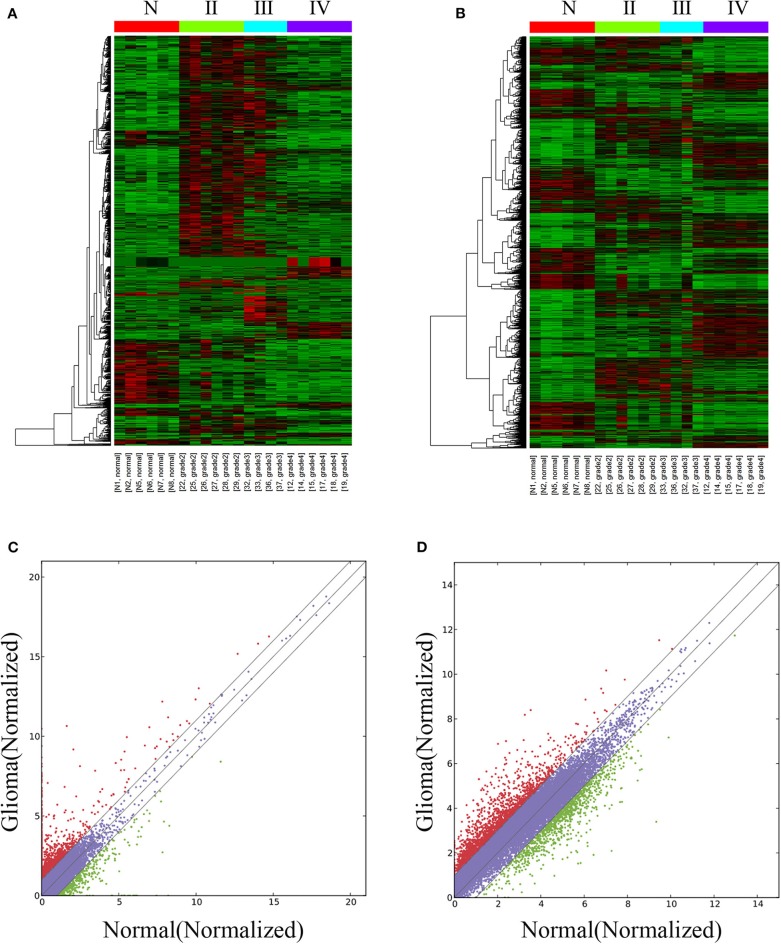
Differentially expressed lncRNAs and mRNAs in glioma tissues and normal tissues. The hierarchical clustering and heat map show differential lncRNA (A) and mRNA (B) expression profiles of all targets among samples: red represents high relative expression, and green represents low relative expression. The variation of differential lncRNAs and mRNAs between the glioma and normal groups is shown in a scatter plot (C,D). The red dots and green dots denote a fold change >2.